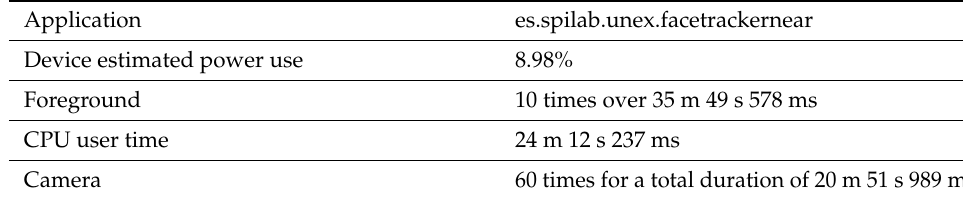
Table 1. Doctor’s device battery consumption.